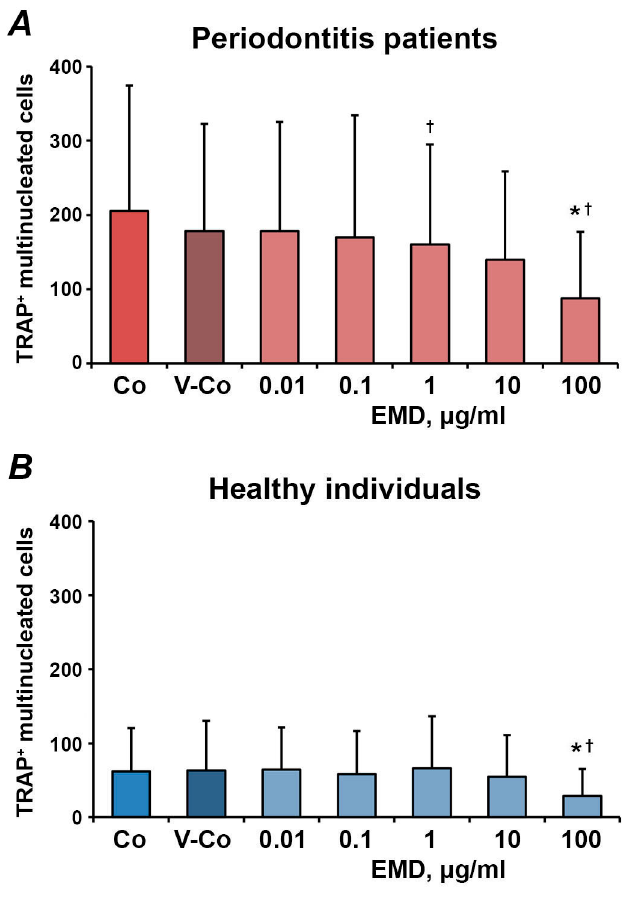
Figure 3. The effect of enamel matrix derivative (EMD) on the formation of osteoclast-like cells from human umbilical vein endothelial cells (HUVECs)-adherent PBMCs. HUVECs were pre-activated with 25 nM TNF- α and 10 U/mL IL-1 β and co-cultured with freshly isolated PBMCs. A HUVECs-adherent fraction of PBMCs was isolated by magnetic separation and used for osteoclast-formation assay in the presence of different EMD concentrations. Cells treated with 0.01% of acetic acid were used as vehicle control (V-Co). Cells without EMD treatment were used as control (Co). Y -axis represents the number of TRAP + multinucleated cells. Data are presented as mean ± SD of 9 periodontitis patients ( A ) and 8 healthy individuals ( B ). *-significantly different compared to V-Co; †-significantly different compared to Co.